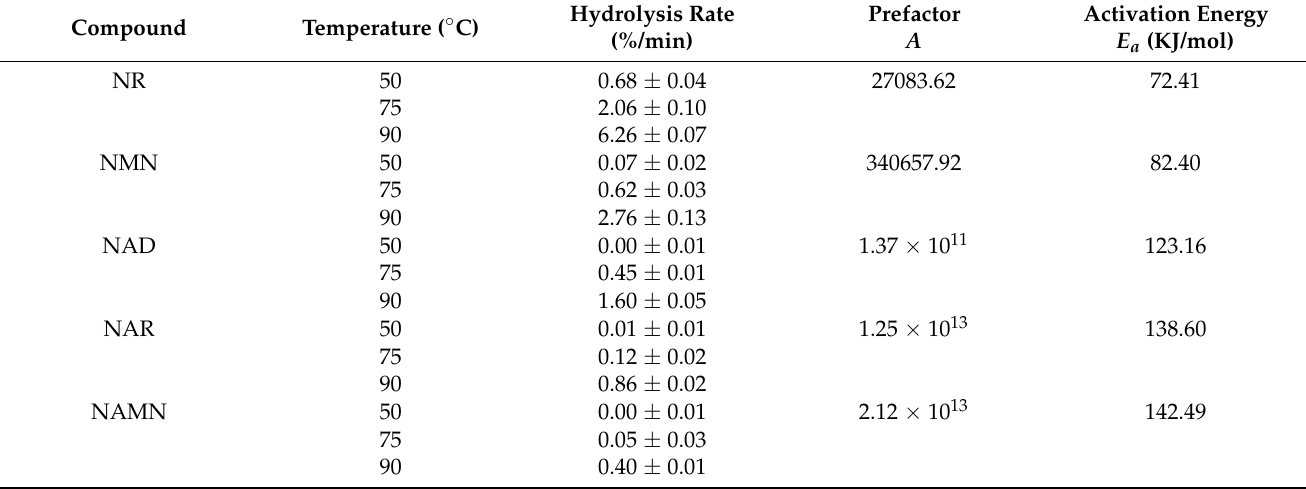
Table 1. Measured hydrolysis rates (%/min) at different temperatures ( ◦ C) and calculated pre- exponential factor A and activation energy E a based on the fitting of the data using the Arrhenius equation (Equation